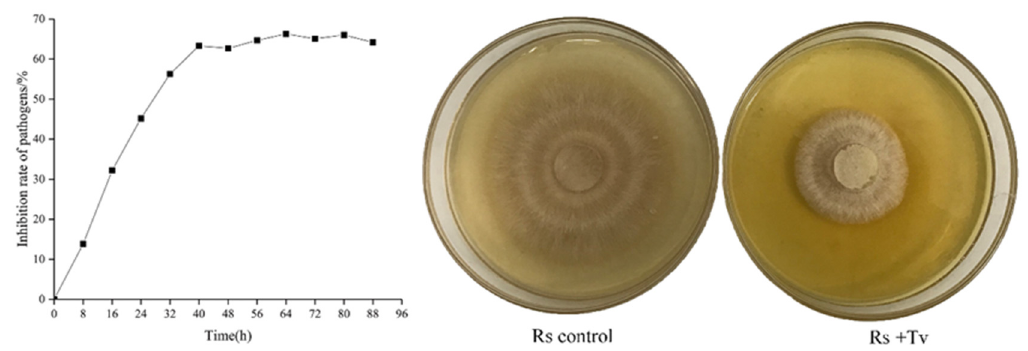
Figure 3. Inhibitory effect of nonvolatile metabolites of T. virens ZT05 on R. solani (Rs) (Control, 20% Tween 80 solution; Rs + Tv, 20% nonvolatile metabolites solution).